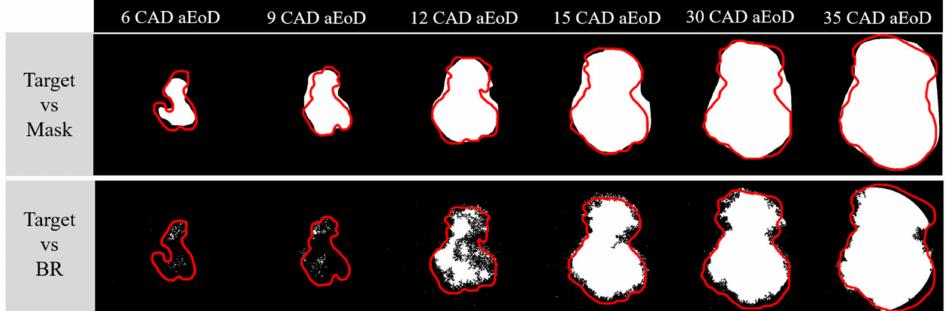
Figure 9. Comparison between Mask R-CNN outputs and BR ones at different instants after the end of the discharge at λ = 1.6. The red lines on the images indicate the contour of the Target flame front whereas the white areas the flame front computed by the algorithms (upper Mask-RCNN and bottom BR).